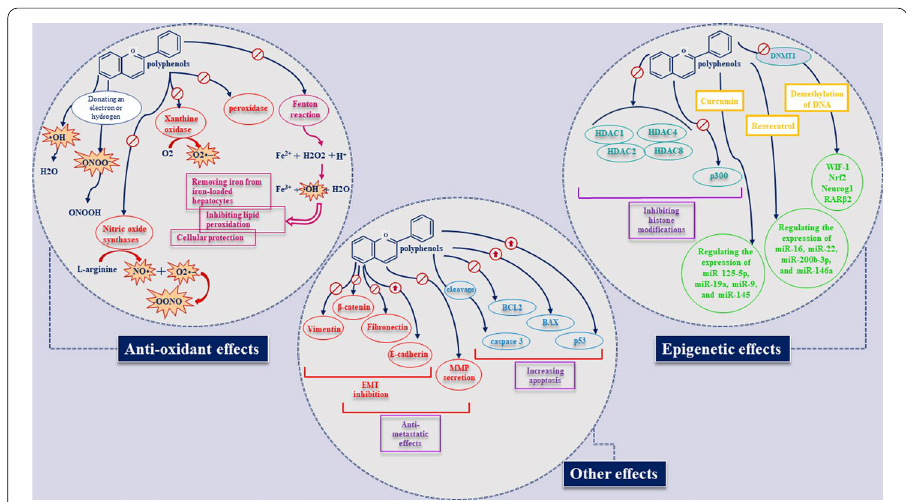
Fig. 2 Some of the anti-cancer effects of polyphenols including epigenetic, anti-metastatic, pro-apoptotic, and anti-oxidant